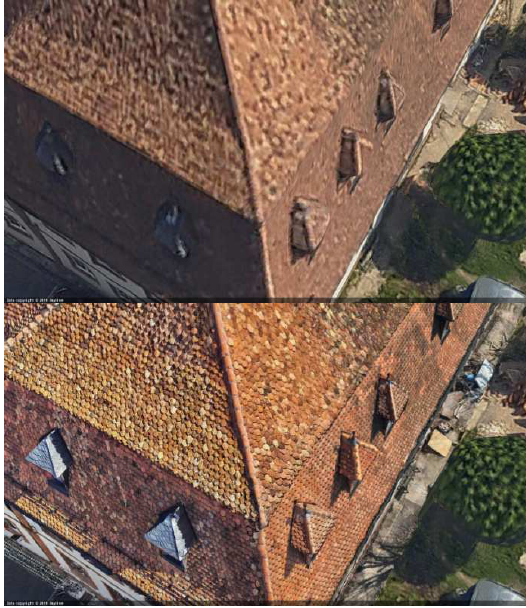
Figure 10 and 11: Details of the roof on the aerial model above at 5 cm GSD and the UAV model below at 0.5 cm